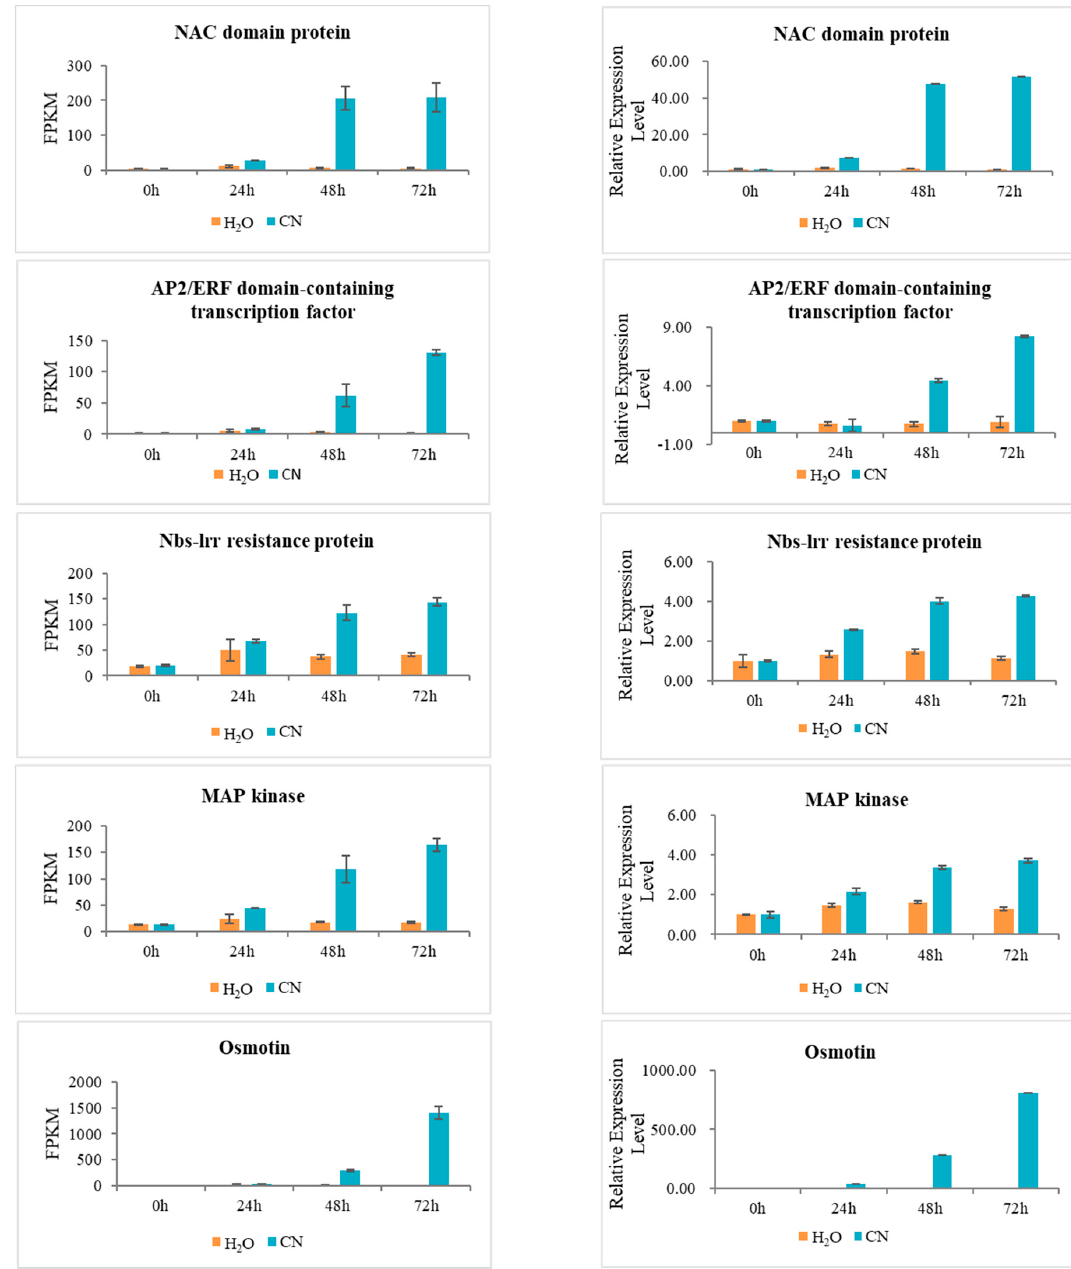
Figure 7. Gene expression profiles of RNA-seq and experimental verification of gene expression levels by qRT-PCR.